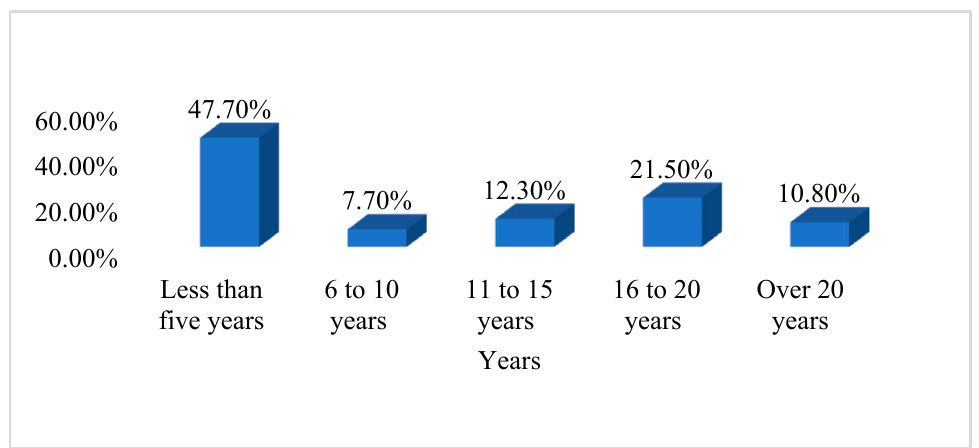
Figure 3. Distribution of respondents according to years of experience in the construction field.